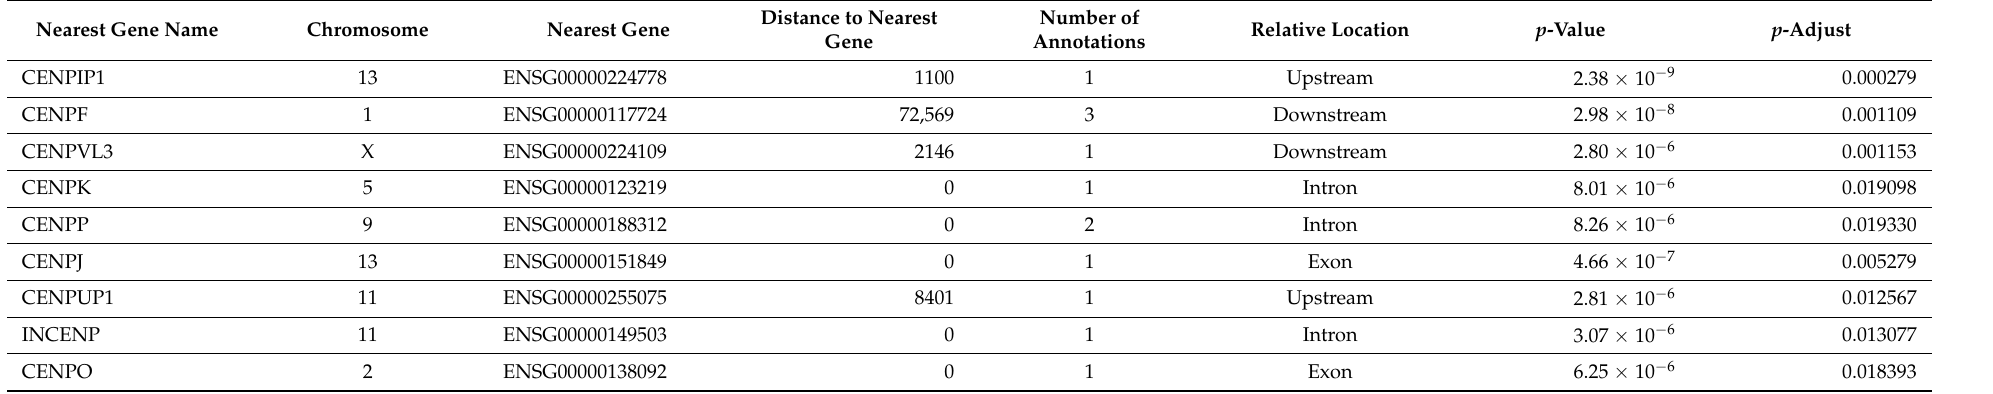
Table 11. Selected EWAS Hits on Centromere Proteins (CENPs); Data from Schrott